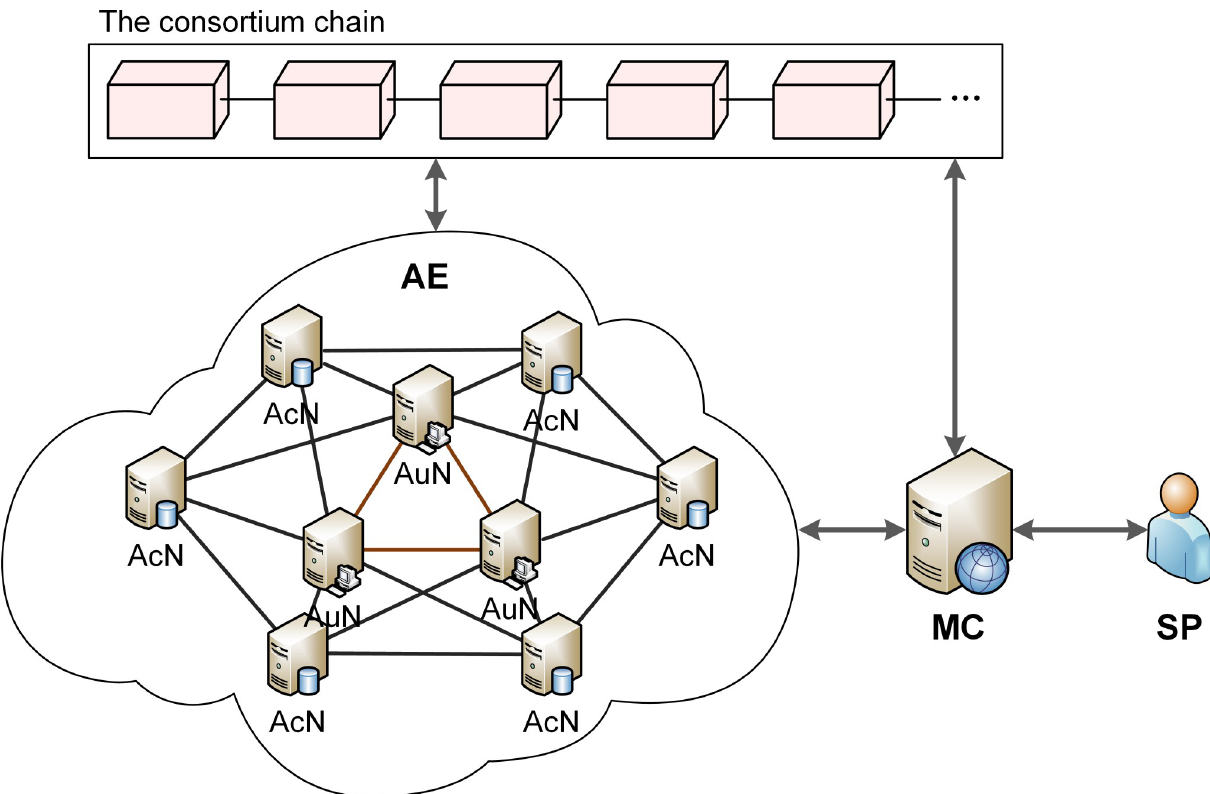
Fig 4. System model of identity authentication for IEDs of